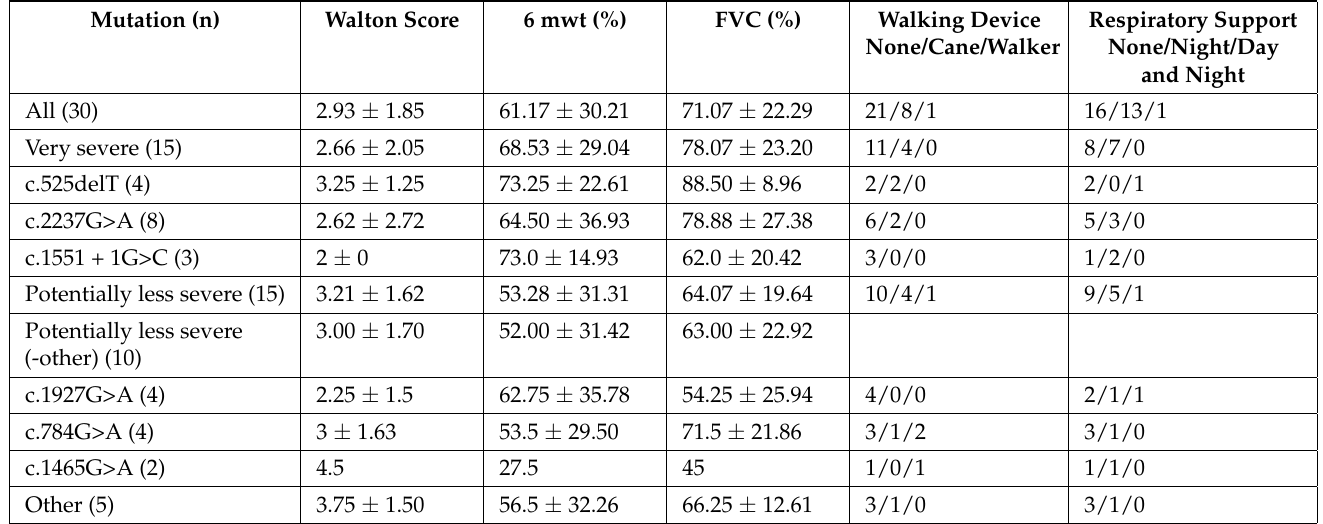
Table 2. Clinical data in sub groups of patients carrying different mutations on the second allele.